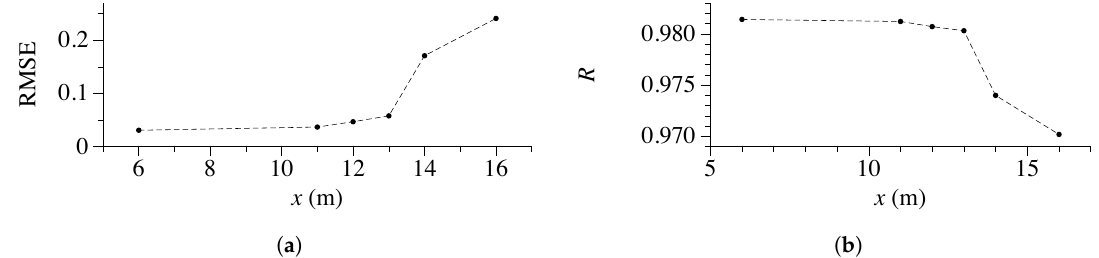
Figure 8. Comparison of accuracy between the numerical and experimental wave signal at different wave gauge positions by ( a ) RMSE for wave phases; ( b ) R